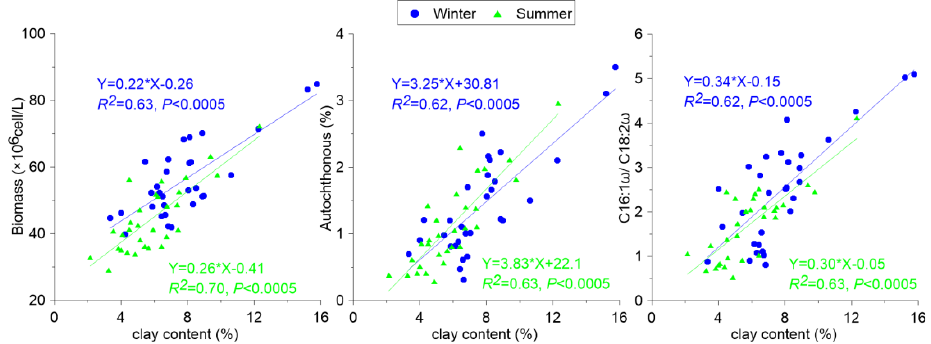
Figure 6. Relationship between photosynthesis and sediment grain size.